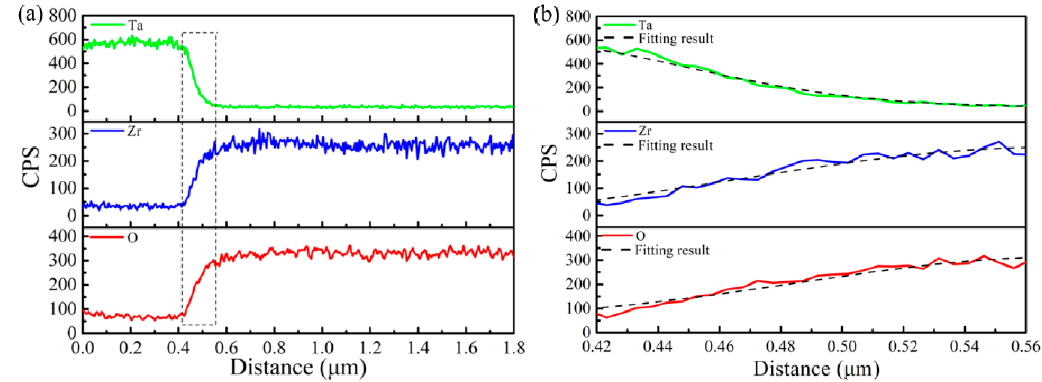
Figure 4. ( a ) Distributions of Ta, Zr and O elements, and ( b ) the fitting results in transition zone analyzed by Fick’s second law.